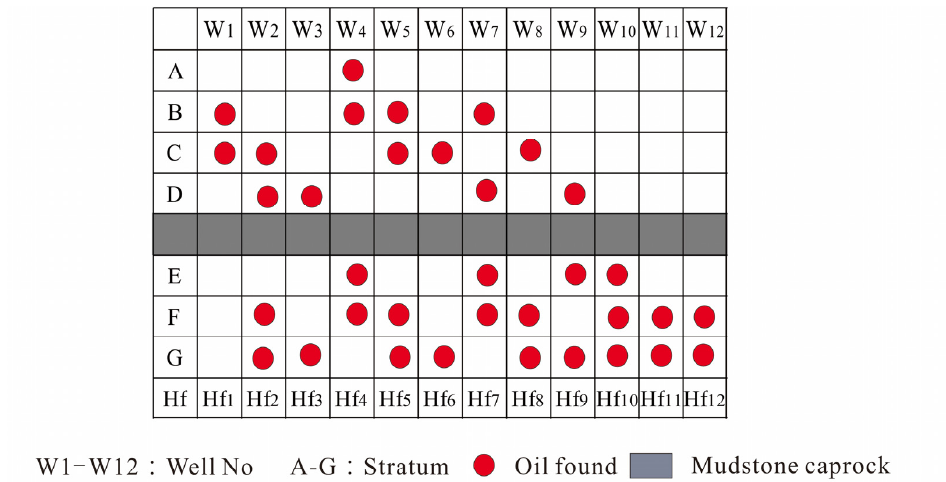
Figure 2. Diagram showing the maximum connected thickness required for hydrocarbon fluid mi- gration through faulted cap